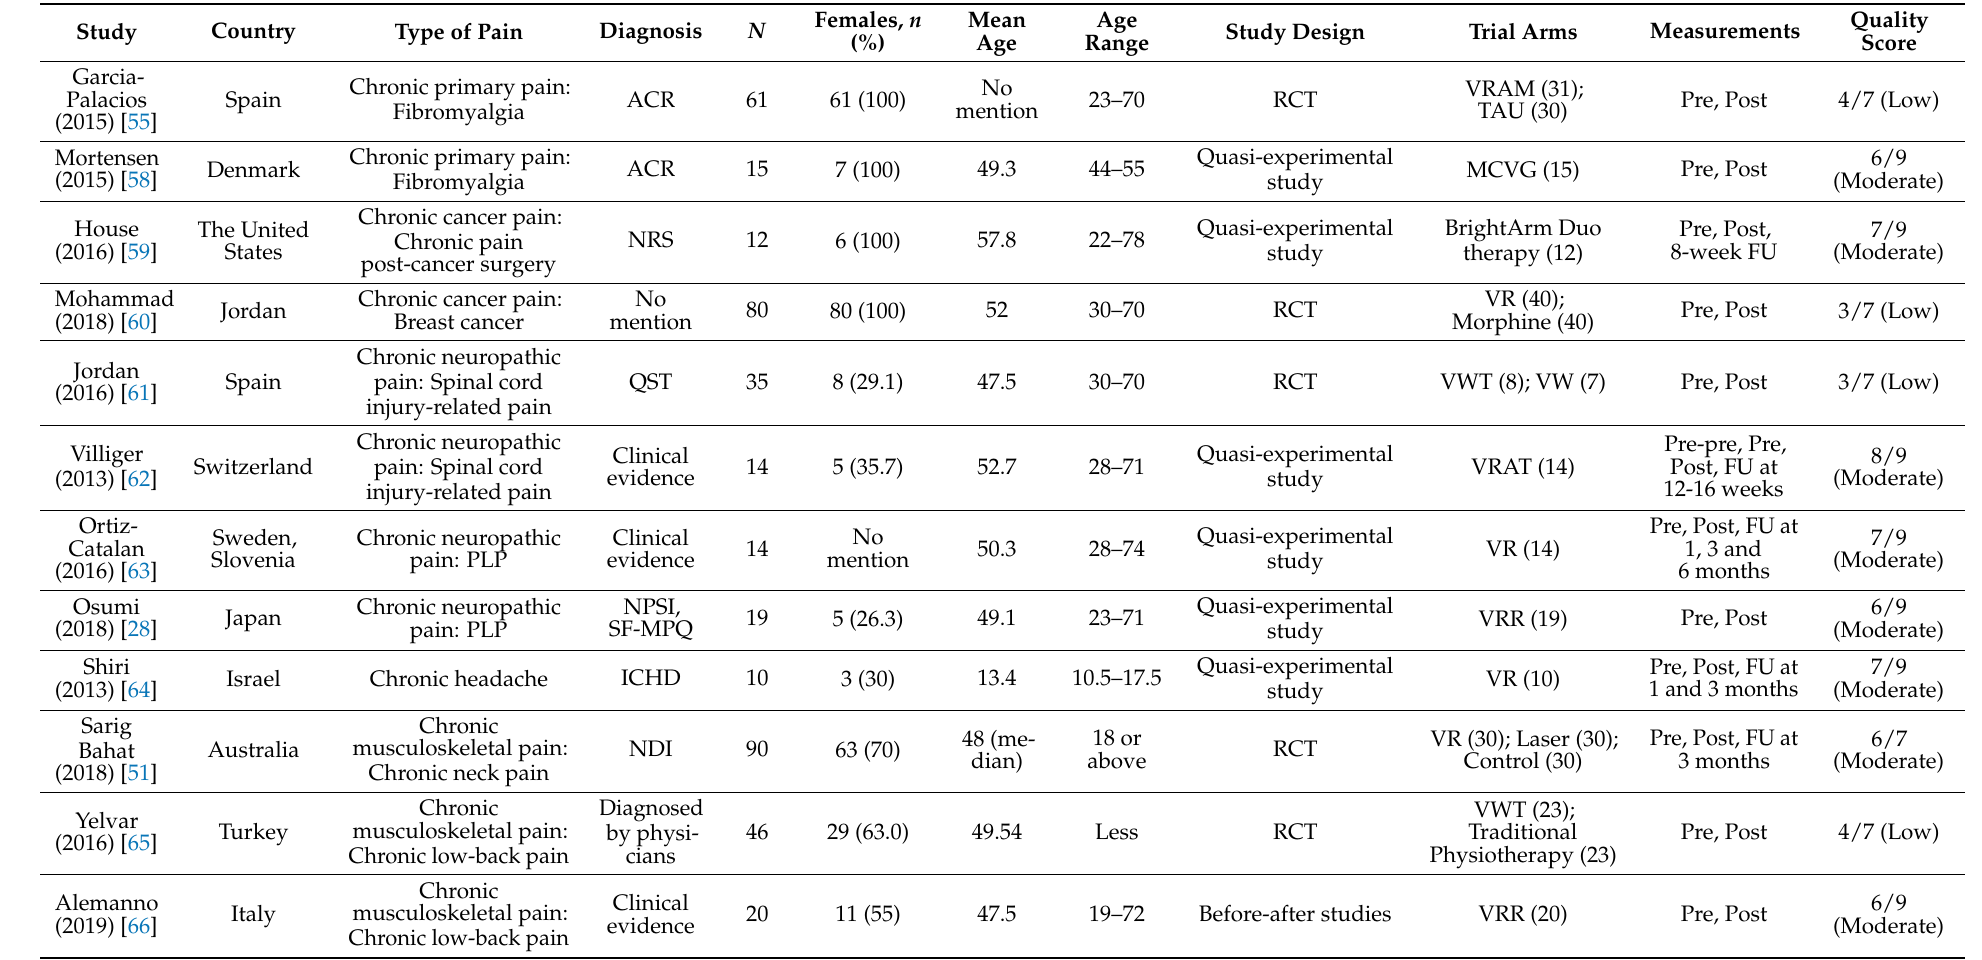
Table 3. Description of study and participants